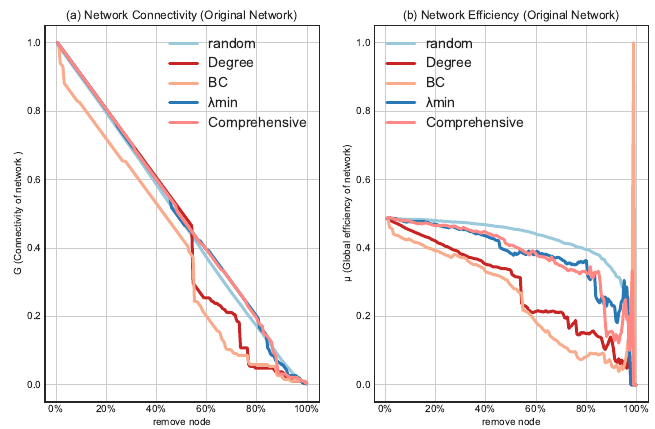
Figure 6. Random attack and malicious attack effect in HNSN. ( a ) The change in original network connectivity after deleting nodes in sequence according to the 5 methods. ( b ) The change in original network efficiency after deleting nodes in sequence according to the 5